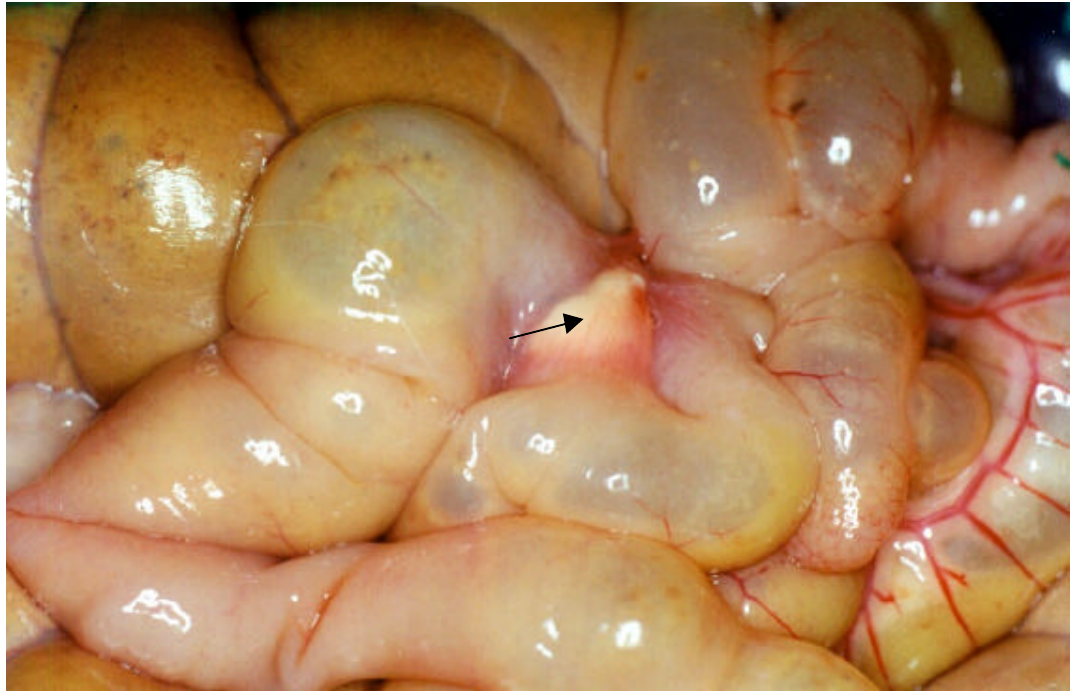
FIGURA 4 – Fotografia da peça operatória da anastomose jejuno-jejunal, mostrando a aderência na linha de cicatrização (seta), sub-grupo Ao (adesivo sintético – 2 pontos) no 14º dia de pós-operatório.